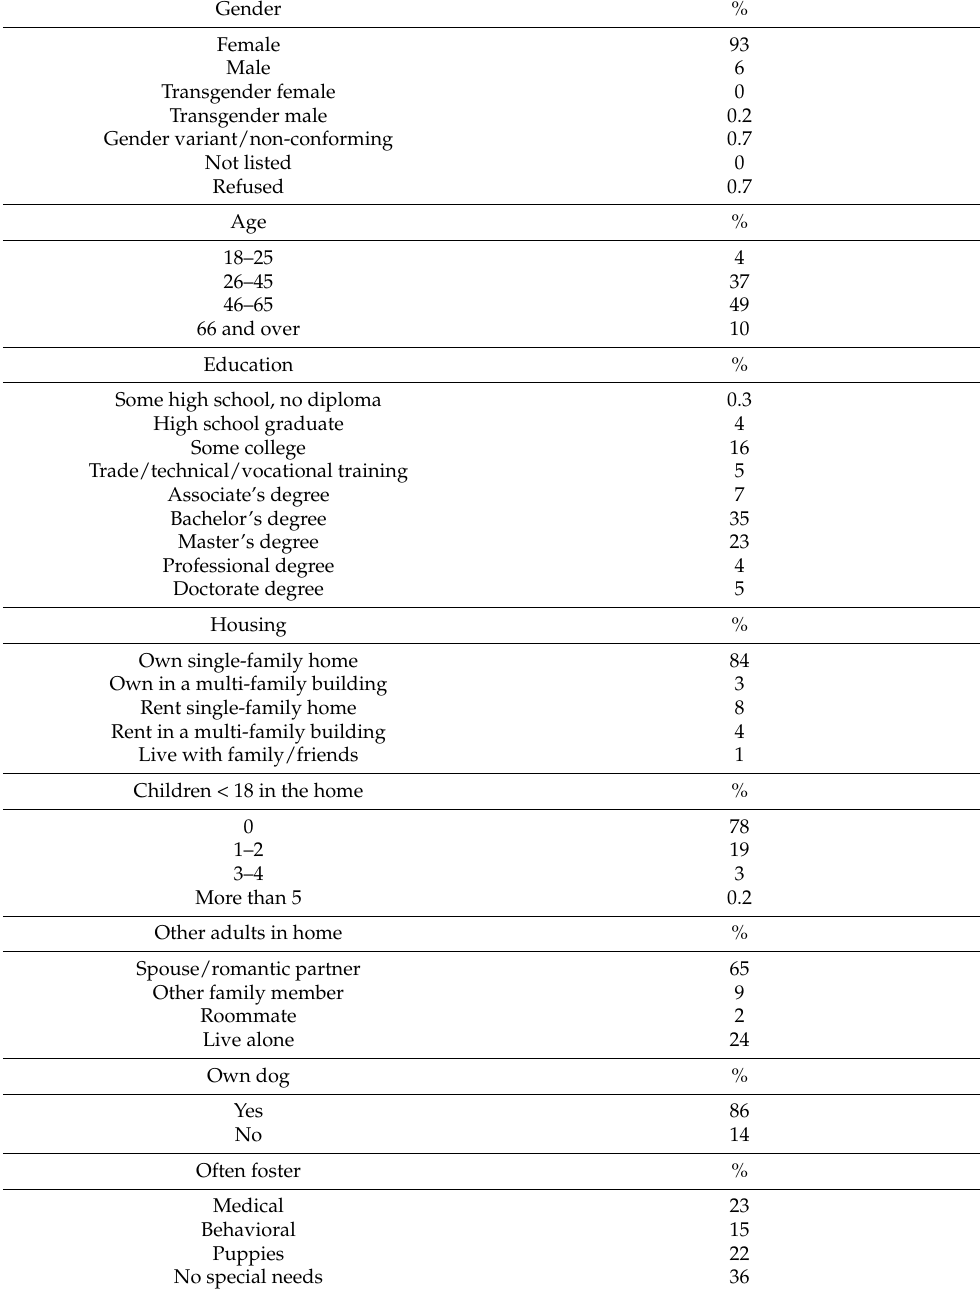
Table 2. Descriptive characteristics of respondents ( n =